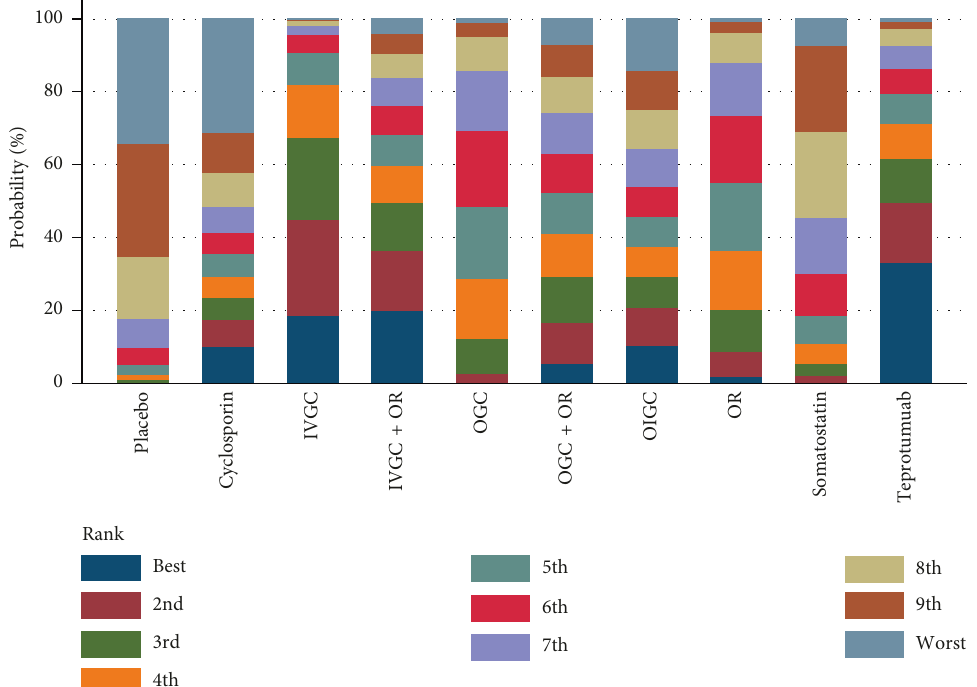
Figure 6: Rank probability of each treatment strategies for proptosis reduction in the network analysis. Table 2: Outcomes of direct comparisons in disease activity. Outcome of disease activity